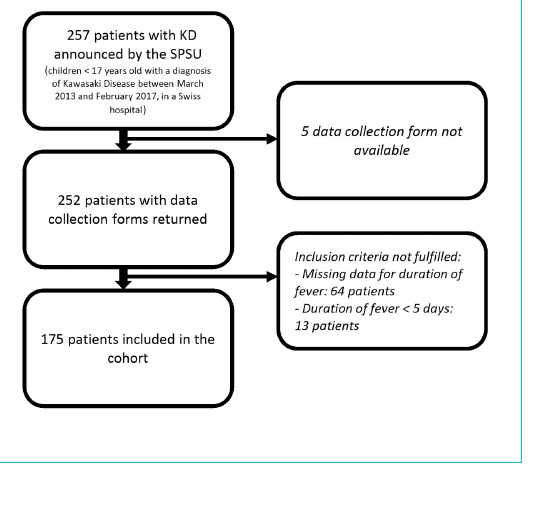
Figure 1: Flow chart of the study showing the inclusion and exclu- sion process of the patients. 257 children were reported by the SP- SU. 5 data collection forms were not returned and therefore were excluded of the study. 64 forms didn’t mention fever duration and 13 patients were diagnosed with Kawasaki disease before com- pleting 5 days of fever. These patients were excluded of the study. 175 patients were included in the cohort.